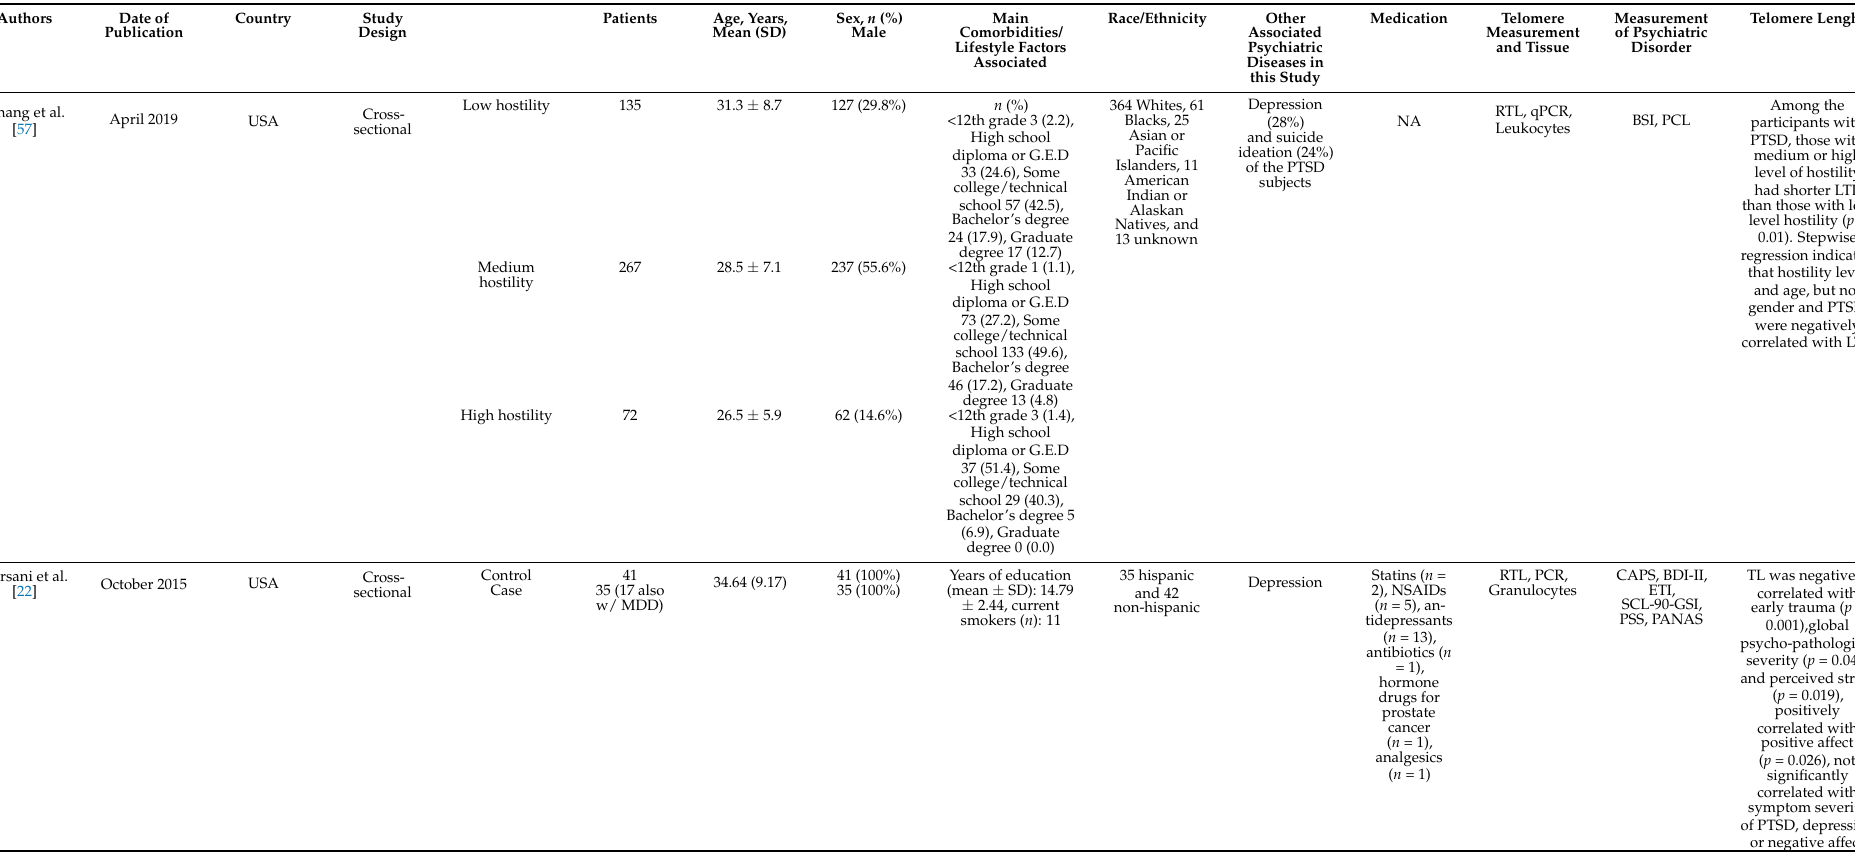
Table 2. Study characteristics, clinical and epidemiological data analysis of PTSD impacts on telomere